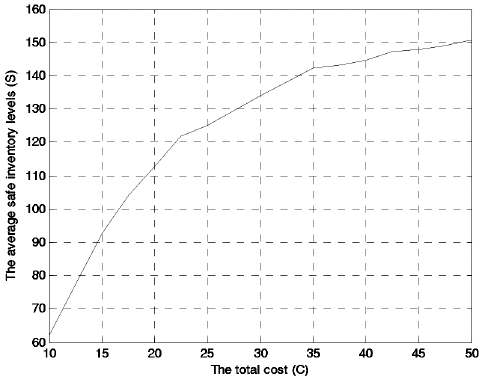
Figure 8. The Pareto optimal